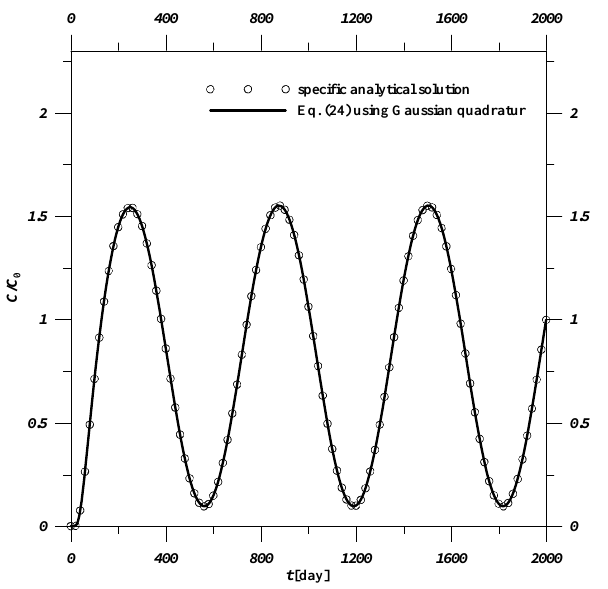
Fig. 6. Comparison of the breakthrough curves at x = 100m from Fig. 6 the numerical integration of Eq. (24) and the specific analytical so- lution for sinusoidal periodic input function ( f (t) = 1 + sin t)